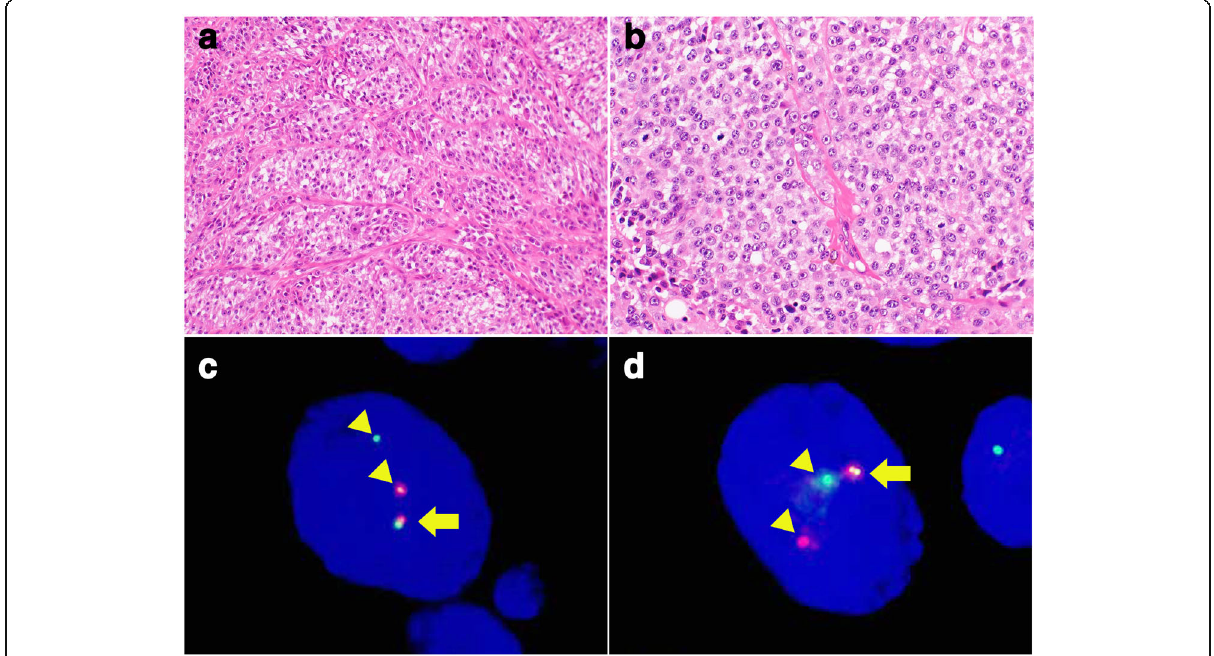
Fig. 1 Pathological findings of CCSST with EWSR1 and ATF1 rearrangements. a CCSSTs showed sheet-like and nested growth patterns of polyhedral tumor cells (200×). b Tumor cells had round nuclei with conspicuous nucleoli and clear to pale eosinophilic cytoplasm (400×). c FISH of EWSR1 split signals. Tumor cells showed EWSR1 split signal with a pair of fused (arrow) and split (arrow head) patterns (1000×). d FISH of ATF1 split signals. Tumor cells showed EWSR1 split signal with a pair of fused (arrow) and split (arrow head) patterns